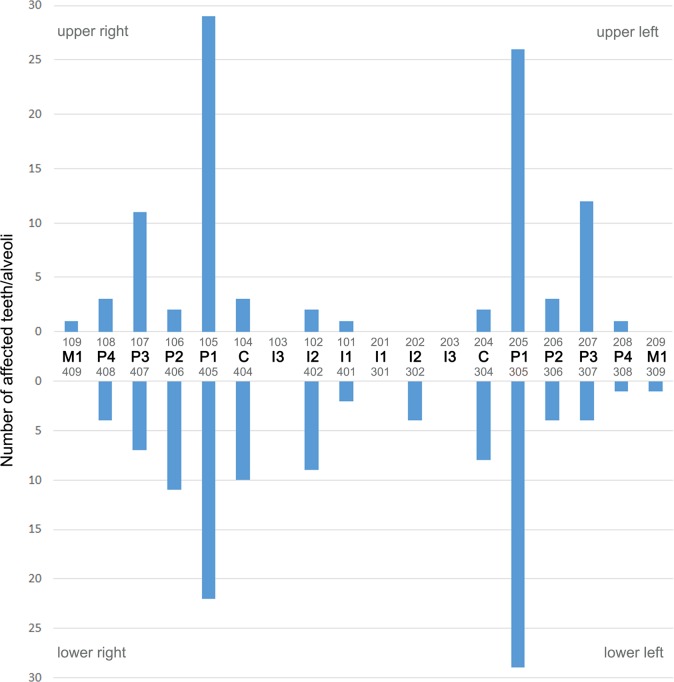
Distribution of periapical lesions visible on external inspection in the permanent dentition of the studied Eastern Atlantic harbor seals (Phoca vitulina vitulina).The first premolar was the most frequently affected tooth position. The teeth are identified both by anatomical terms and the numbering of the modified Triadan system (see Fig 1).